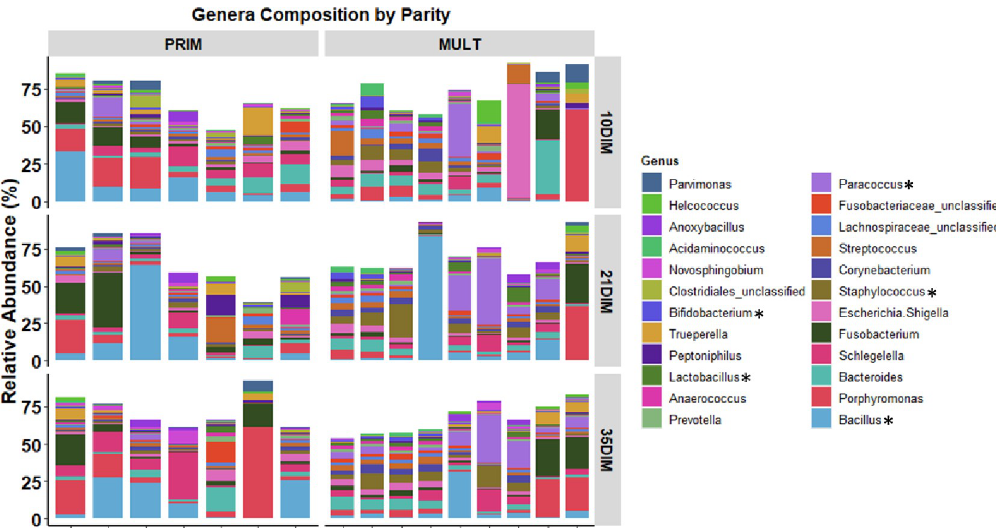
Fig 4. Relative abundance of the most influential bacterial genera in clinically healthy primiparous (PRIM, n = 7) and multiparous (MULT, n = 9) postpartum dairy cows in uterine samples collected at 10, 21, and 35 d in milk (DIM). There was an overall lower abundance of Anaerococcus , Bifidobacterium , Corynebacterium , Lactobacillus , Paracoccus , Staphylococcus , and Streptococcus and higher abundance of Bacillus , Fusobacterium , and Novosphingobium in PRIM than MULT ( P < 0.05). Asterisks indicate differences between parity groups analyzed via mixed linear regression models.